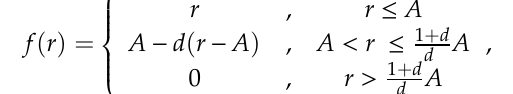
Figure 4. Smooth Clipping function.